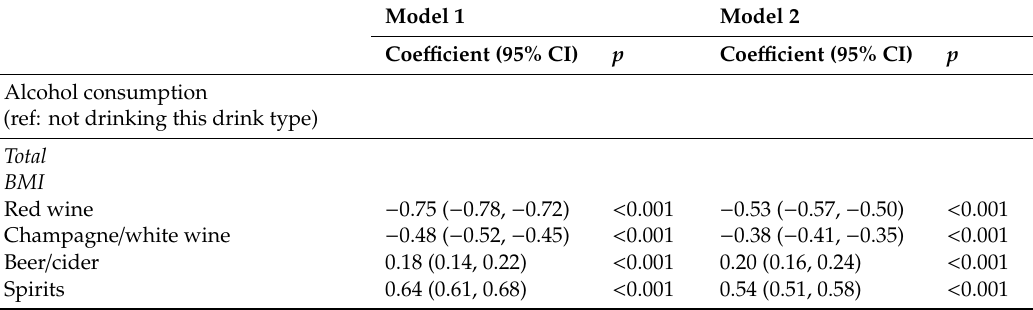
Table 3. Multivariable-adjusted associations between BMI and body fat percentage with types of alcoholic beverages consumed in the UK Biobank ( n =